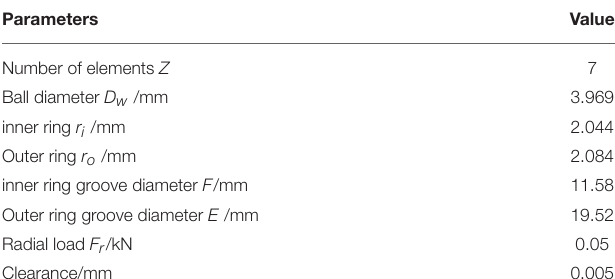
TABLE 1 | Bearing parameters.